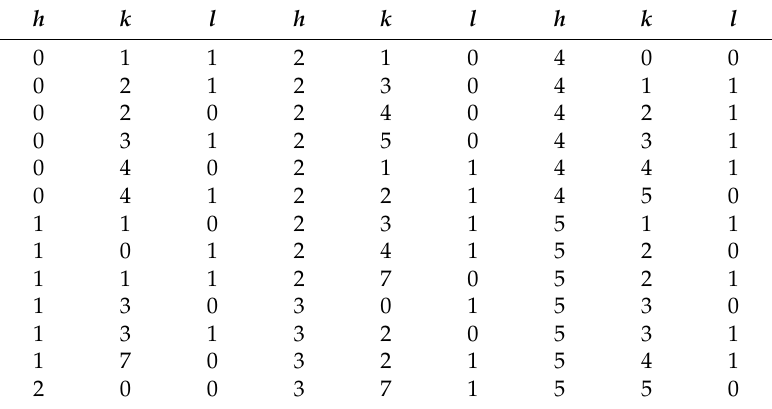
Figure 7. Illustrated reciprocal image prepared by combining the data of the GI-XD images (open black circle; Figure 5a) and the in-plane profiles (filled blue circle; Figure 6c). Open red circles indicate the reflection spots determined based on the result obtained with the GIXD image with synchrotron radiation (Figure 1b). Table 1. The ( hkl ) reflections measured using commercial X-ray sources in this study.